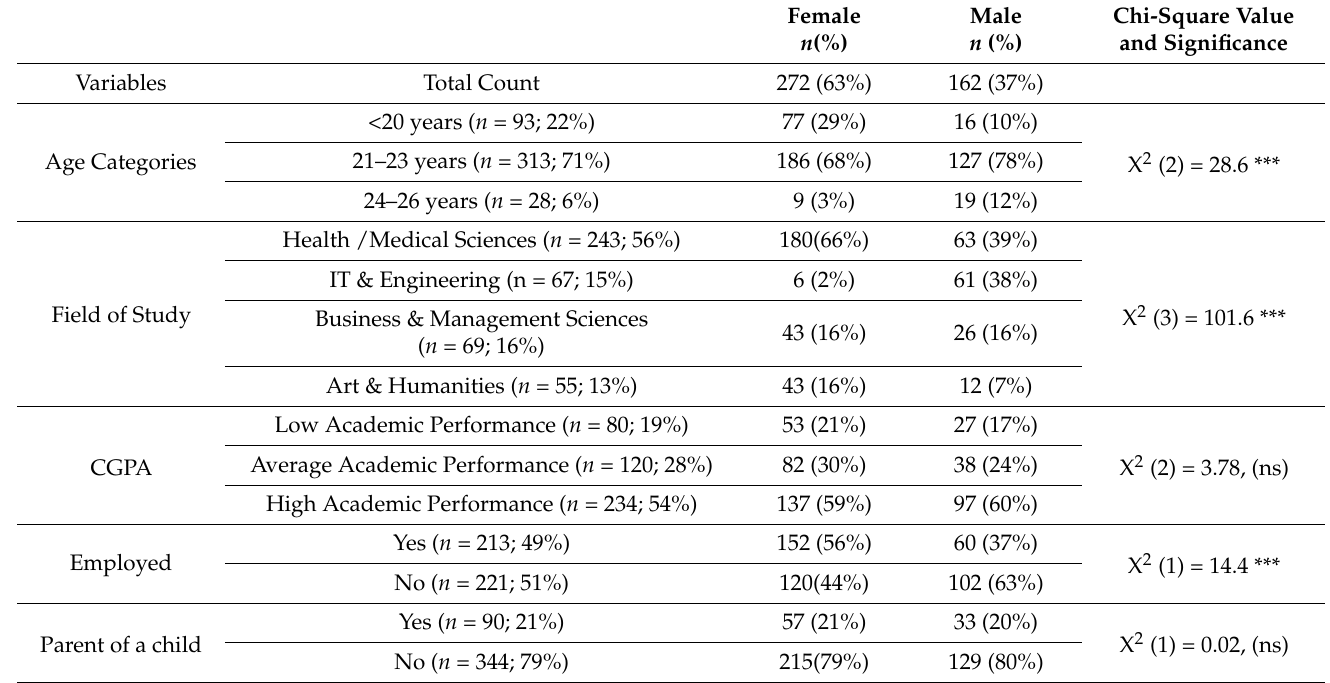
Table 1. Demographics and educational characteristics of students across genders ( n =